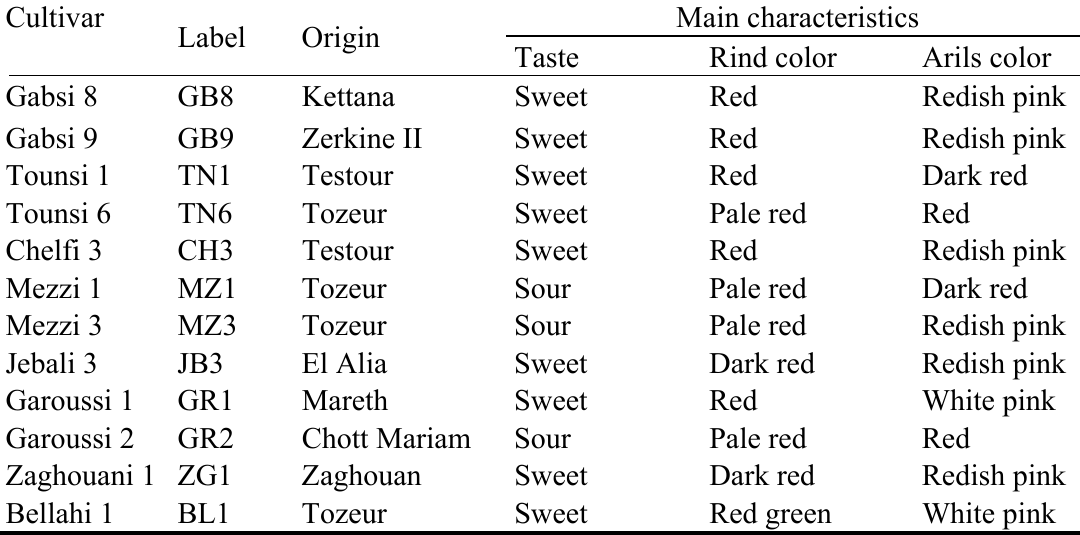
Table 3. List of 12 Tunisian pomegranate cultivars, their origin and main